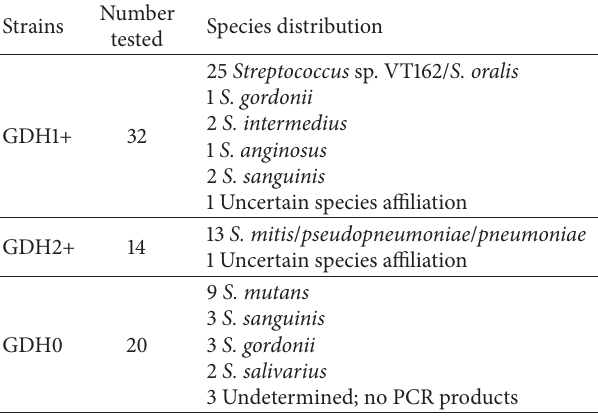
Table 2: Species assignment based on MLSA.